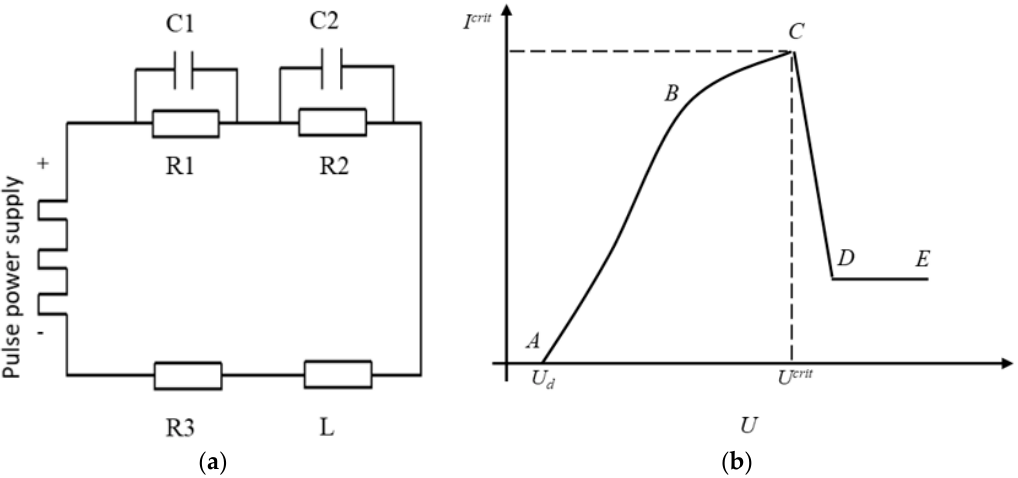
Figure 2. Equivalent circuit diagram and voltage current characteristic curve of ECDM. ( a ) Equivalent circuit diagram. ( b ) Voltage current characteristic curve of ECDM.